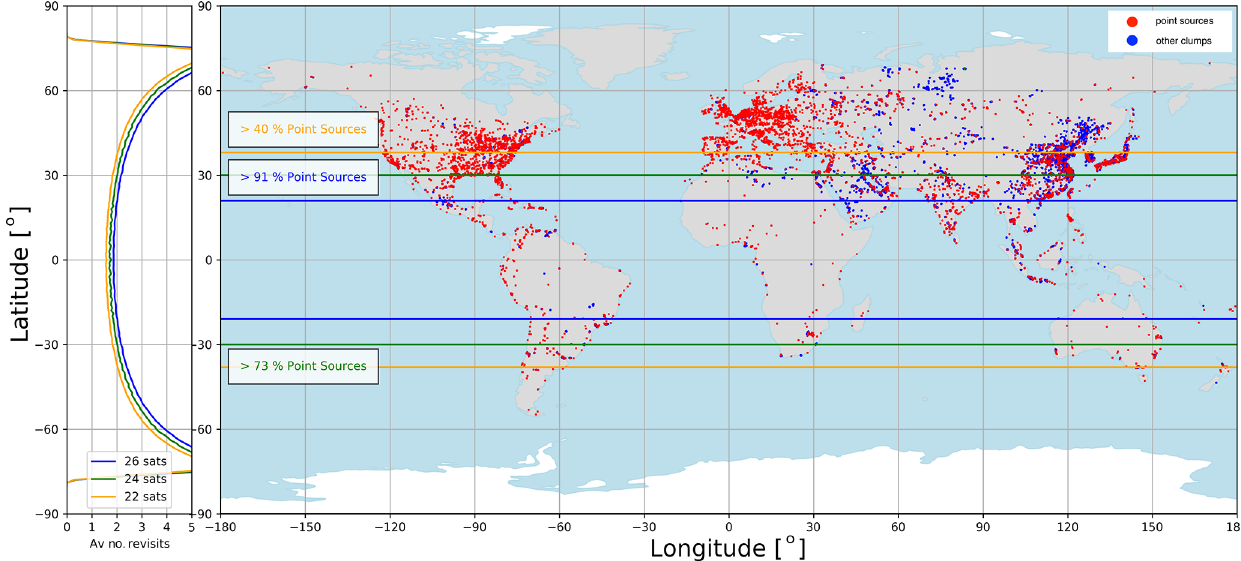
Figure 3. Map of hotspots (point sources in red, and other types of emission clumps in blue) with an emission rate compatible with the detectability of an X CO plume around noon with a 1ppm precision spaceborne instrument. Yellow, green and blue horizontal lines give the 2 minimum latitude for better intra-day revisit for a constellation of 22, 24 and 26 satellites, respectively. The left panel gives the corresponding average number of revisits as a function of latitude for a constellation of 22, 24 and 26 satellites,